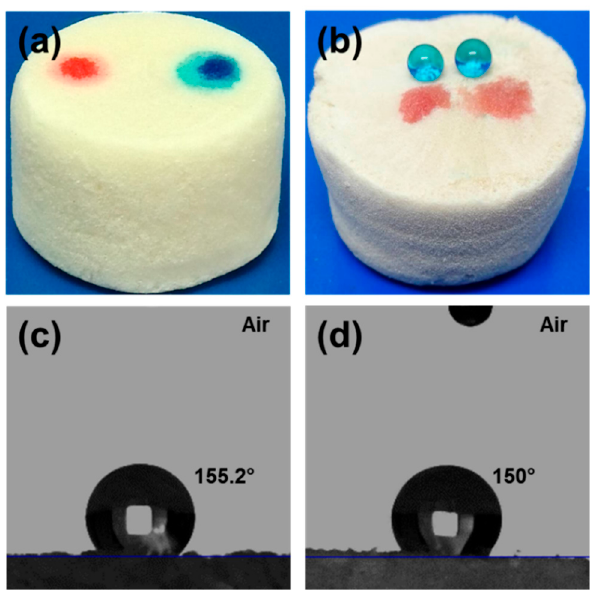
Figure 7. Photographs of water and oil droplets on the surface of the original aerogel ( a ) and the modified aerogel ( b ); the water contact angle of the modified aerogel: Water droplet is sitting on the outside surface ( c ) and inside surface ( d ) of the aerogel.